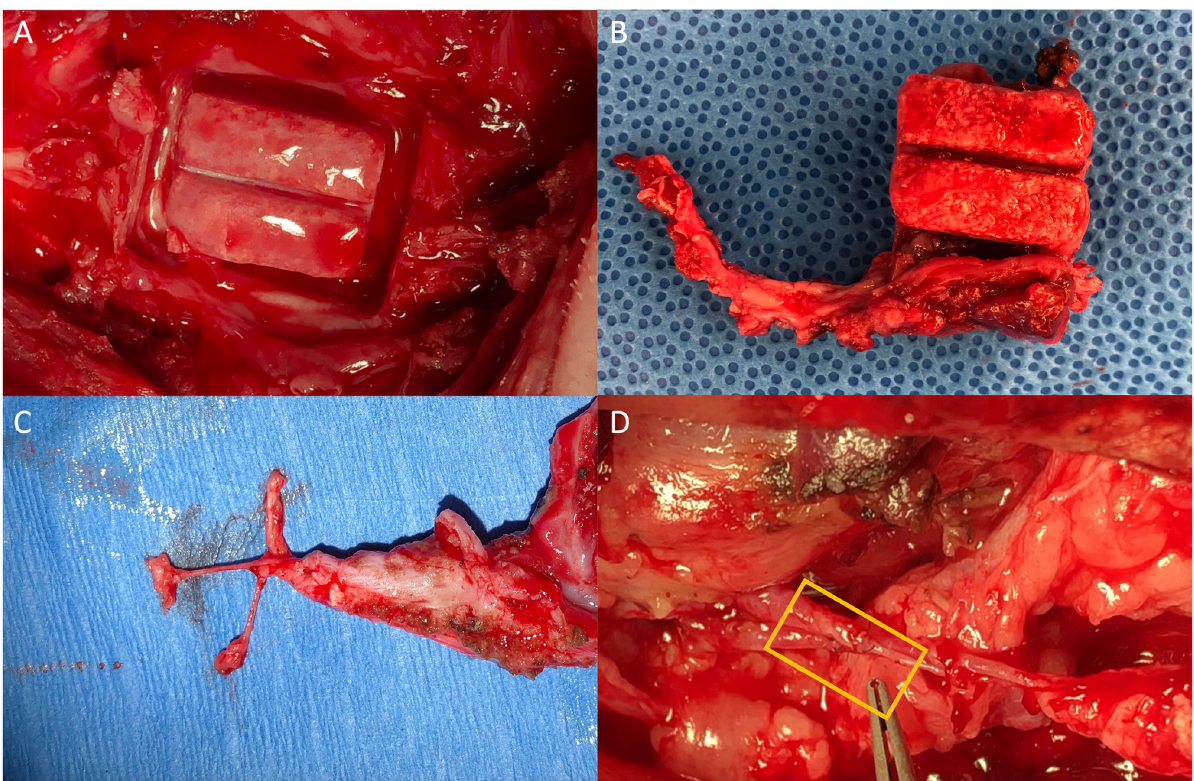
Fig 4. Bioreactor harvest and mandibular reconstruction. Appearance of the bioreactor site after removing the bioreactor from the newly generated bony tissue (A) the grooved tissue after removal along with the vasculature (B), the isolation of the nerve, artery, and vein located within the pedicle (C), and the microvasculature anastomosis (D) of the flap (left) with the systemic circulation (right) with yellow box showing sutured